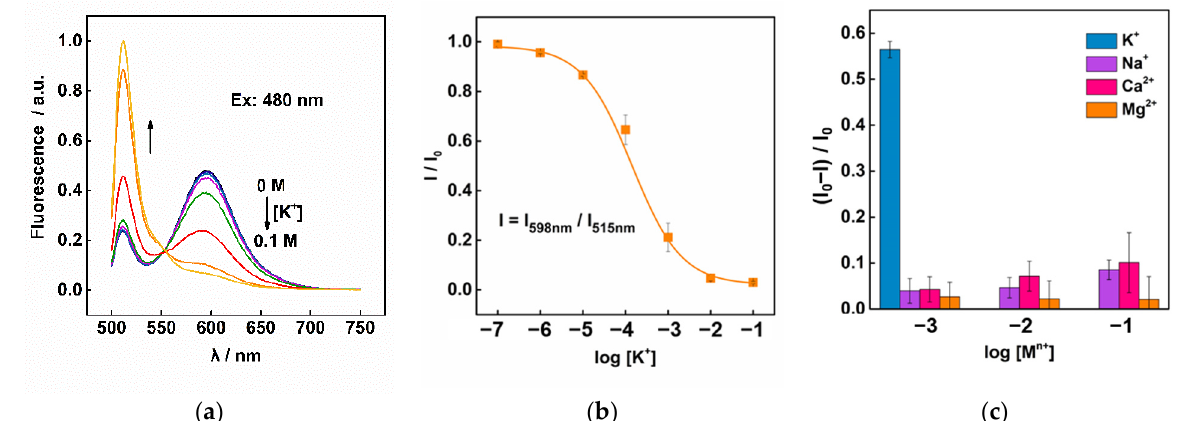
Figure 3. ( a ) Fluorescence emission spectra of the K + -selective nano-optodes excited at 480 nm with increasing K + concentration as indicated; ( b ) fluorescence calibration curve of the K + -selective nano-optodes at different K + concentrations; I 0 represents initial value (without K + ) of the intensity ratio between 598 and 515 nm. ( c ) Selectivity of K + -selective nano-optodes over Na + , Ca 2+ , and Mg 2+ .